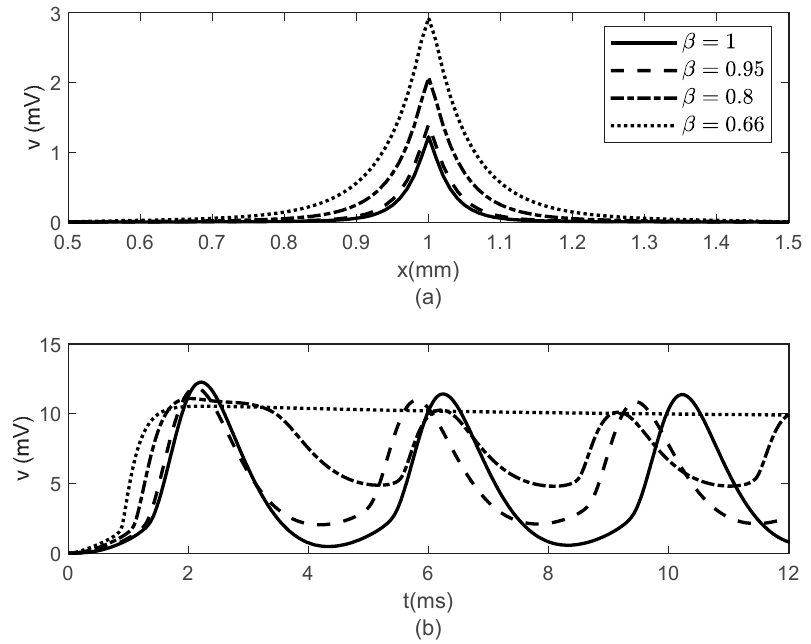
Figure 8. ( a ) Spatial variations of v ( x , t ) at t = 0.1 ms, and ( b ) temporal variations of v ( x , t ) at x = 700 µ m for various values of β . Here, p = 0.25, q = 0.75, and α = 0.65.